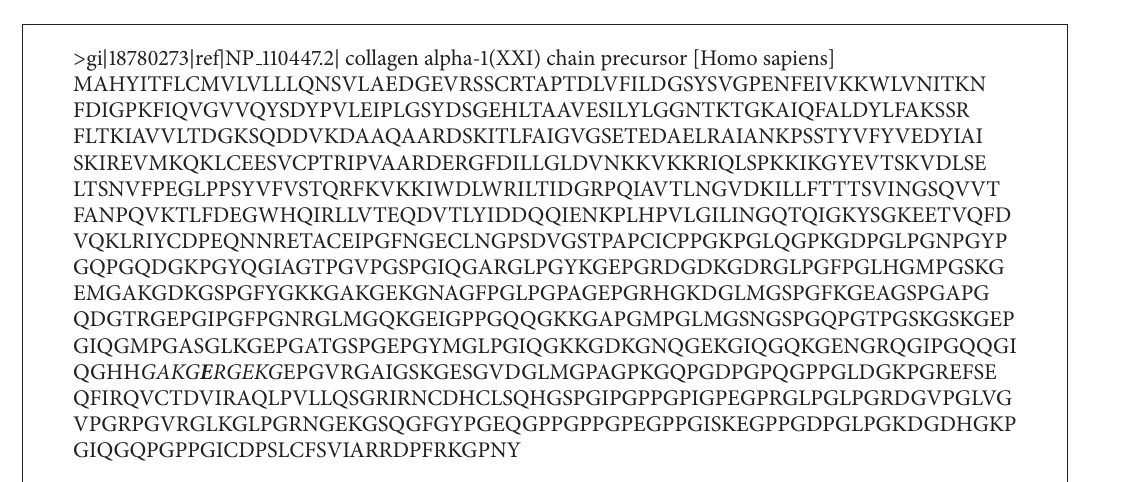
GIQGQPGPPGICDPSLCFSVIARRDPFRKGPNY Box 1: The sequence of aa of the human collagen type 1 protein. The peptide of similar characteristics in human collagen type 1 protein and Prevotella sp. protein is observed in